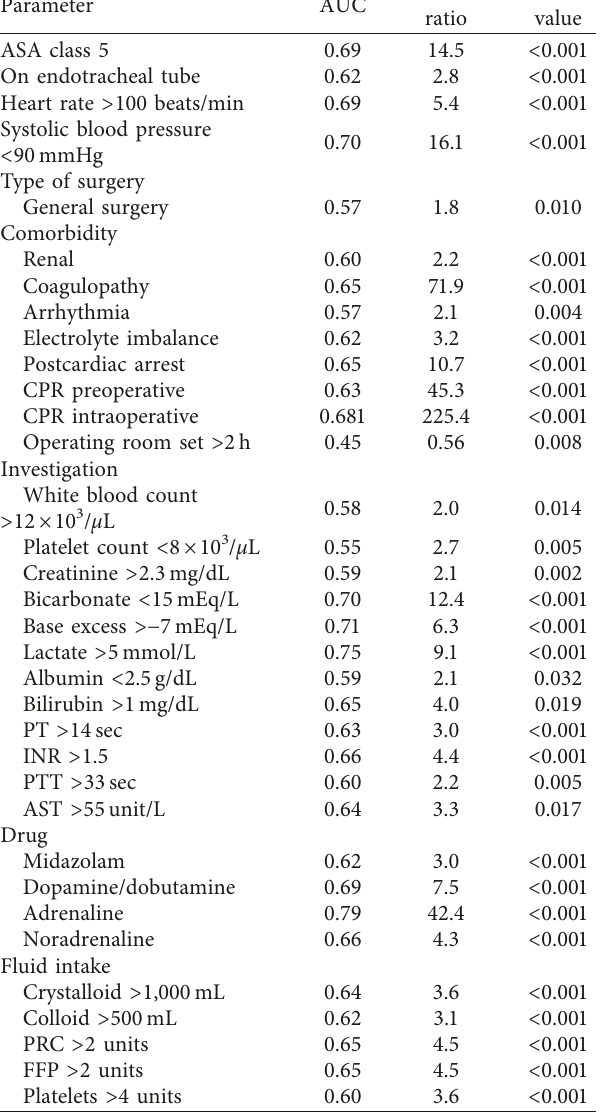
Table 3: Relevant risk factors according to univariate analysis. Table 4: Results of multivariate analysis and the emergency surgery mortality (ESM) score.